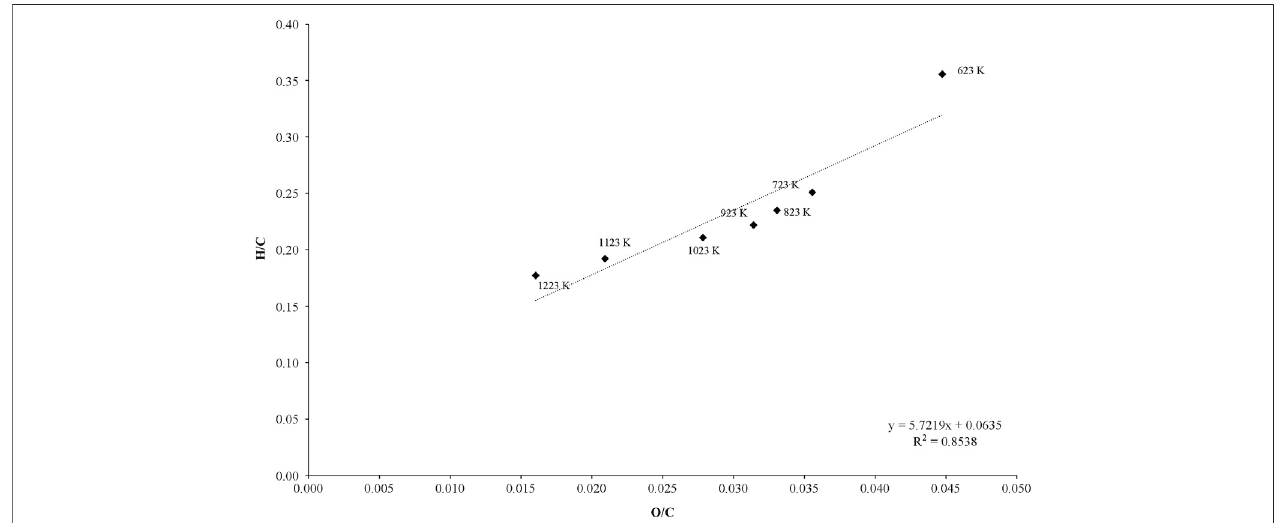
FIGURE 4 | The van Krevelen plot for elemental ratios in bamboo chars prepared at different temperatures.